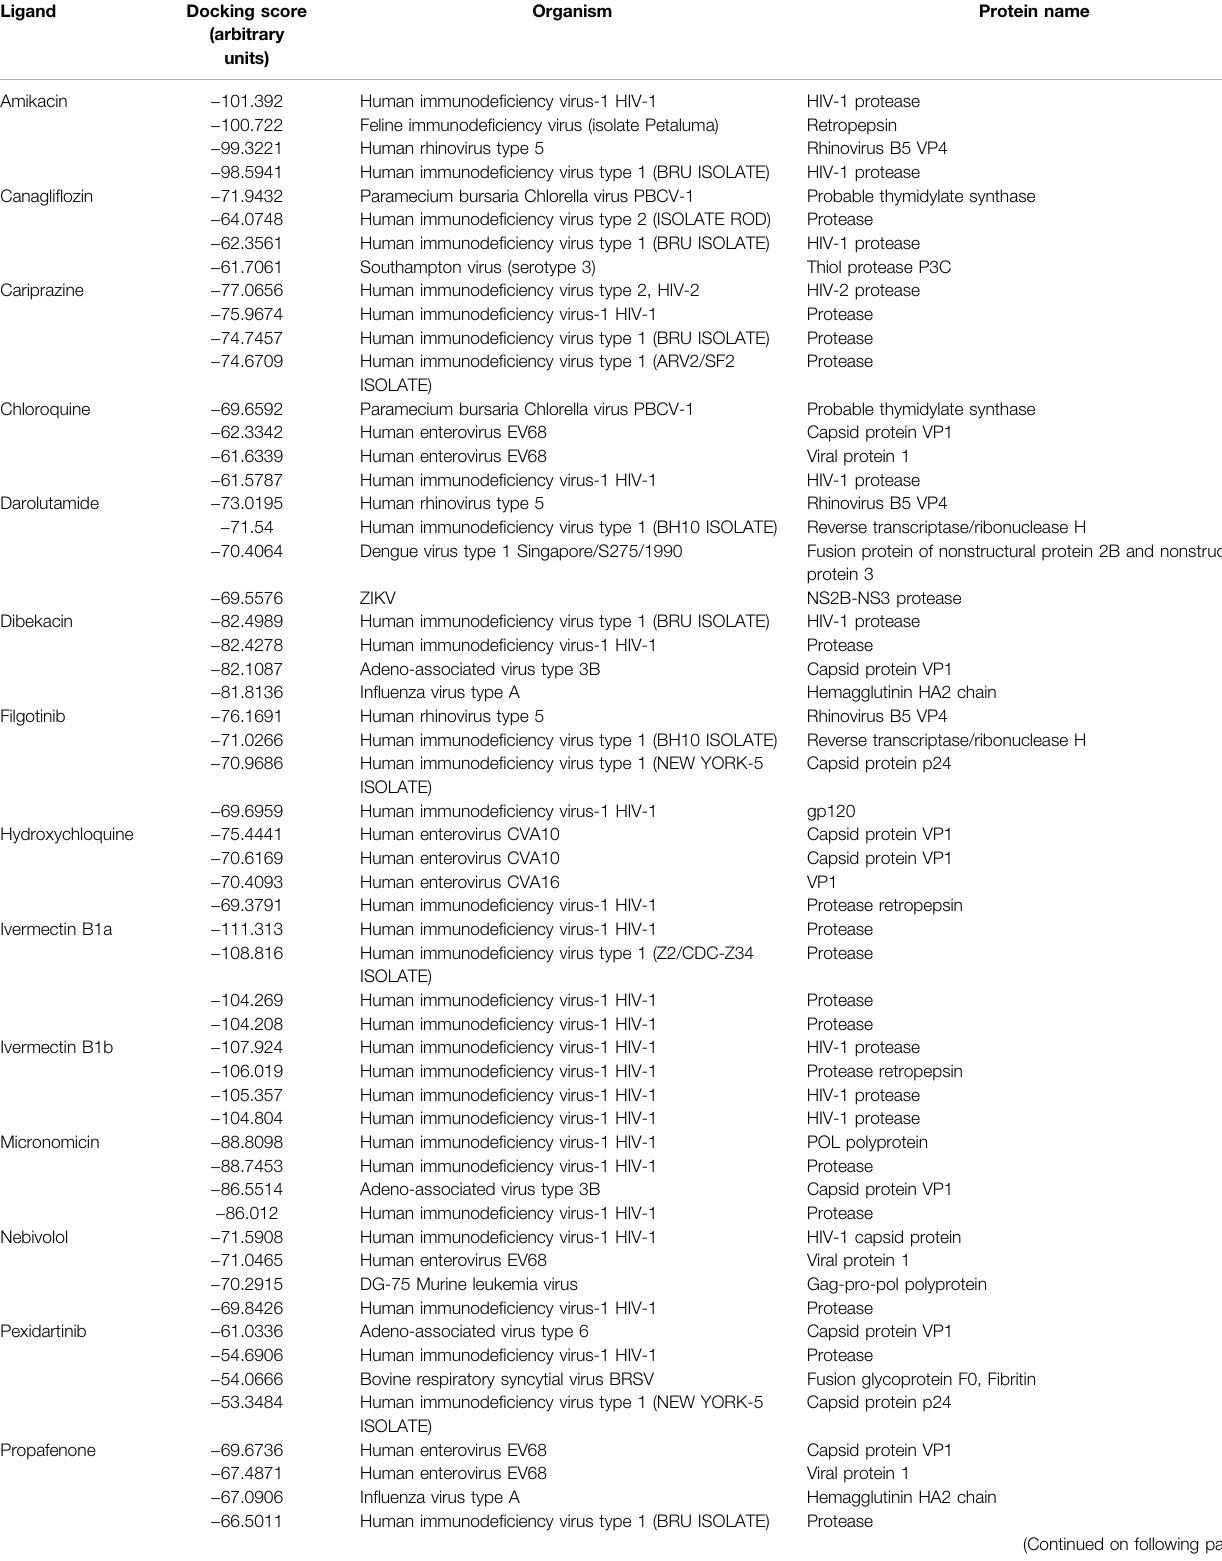
TABLE 3 | Identi fi ed viral proteins with the highest scores in the inverse molecular docking experiment.